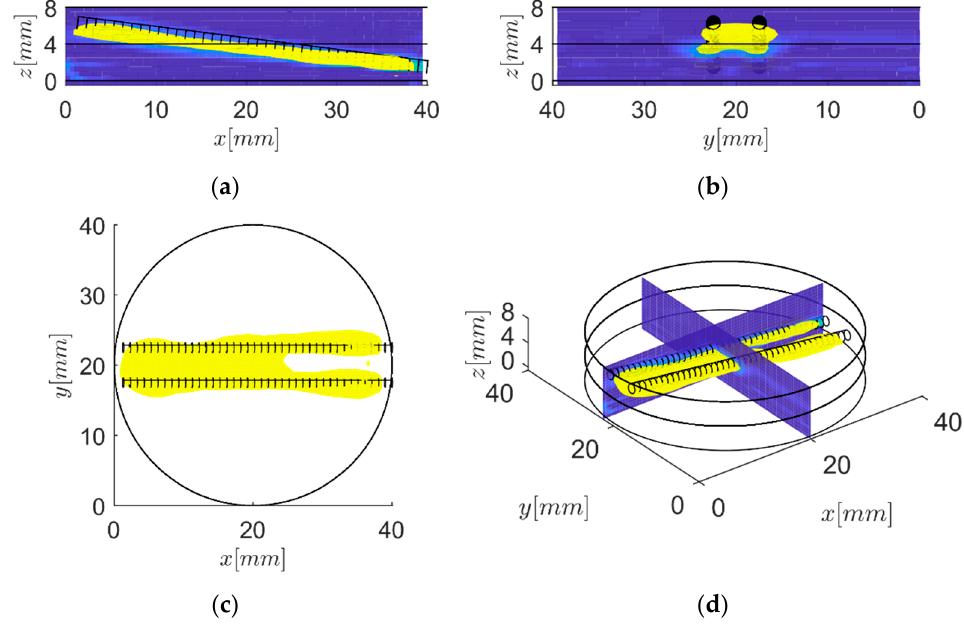
Figure 5. Visualization of the reconstructed cylindrical steel rods. The black circles indicate the target shape. The cross-section of the steel rods was elliptical. This is a consequence of the better resolution in depth compared to the lateral direction. ( a ) Front view. ( b ) Side view. ( c ) Top view. ( d ) 3D view. Nine neighbored pixels were averaged to reduce the noise level from 25 mK for each camera pixel to 8.33 mK. For the maximum of the measured temperature field of 3.12 K, this gives an SNR of 375. In Figure 6a, the temporal temperature with respect to the experimental data and reconstructed data is depicted for different positions, where T mess is the measured temperature at ( x , y ), T smo is the averaged measurement over nine neighbored pixels, and the reconstructed temperature field T rec was calculated from the virtual wave using Equation (5). The zoom at the lower right position emphasizes the noise of the experimental temperature data. Herein, one can see the excellent filter effect of the T-SVD. Figure 6b shows the experimental and reconstructed temperature field normal to the steel rods for t = 20 s at different x positions.